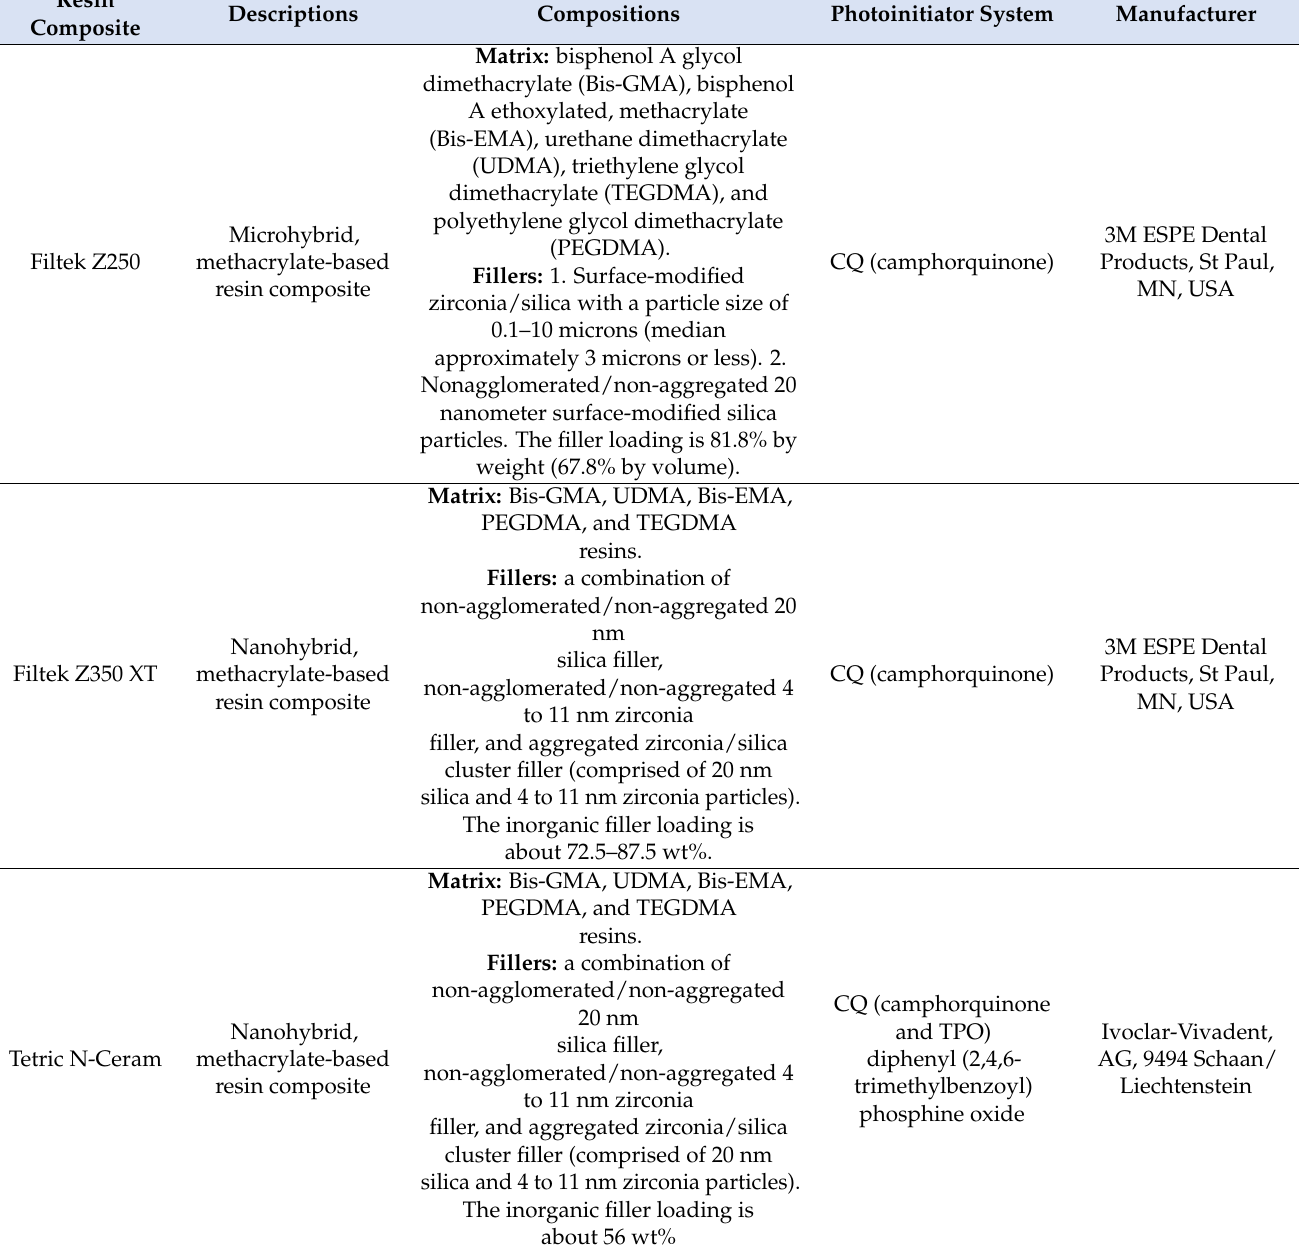
Table 1. Description of the resin composites used in this